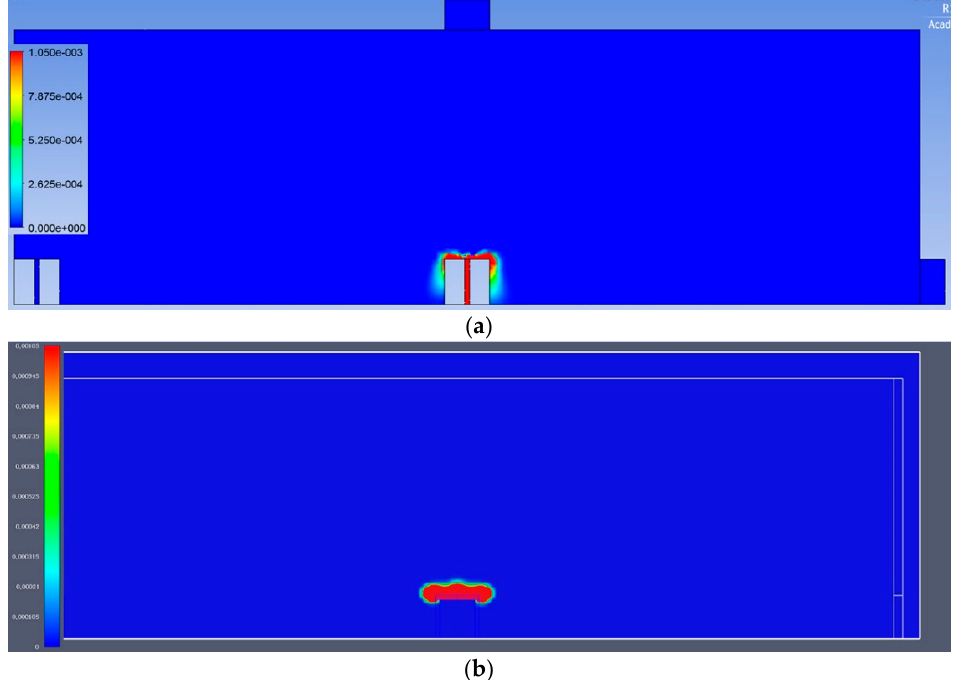
Figure 7. Comparison of propane dispersion for 5% concentration of LEL for time 10 s: ( a ) propane release calculated with Ansys software; ( b ) propane release calculated with FDS software.